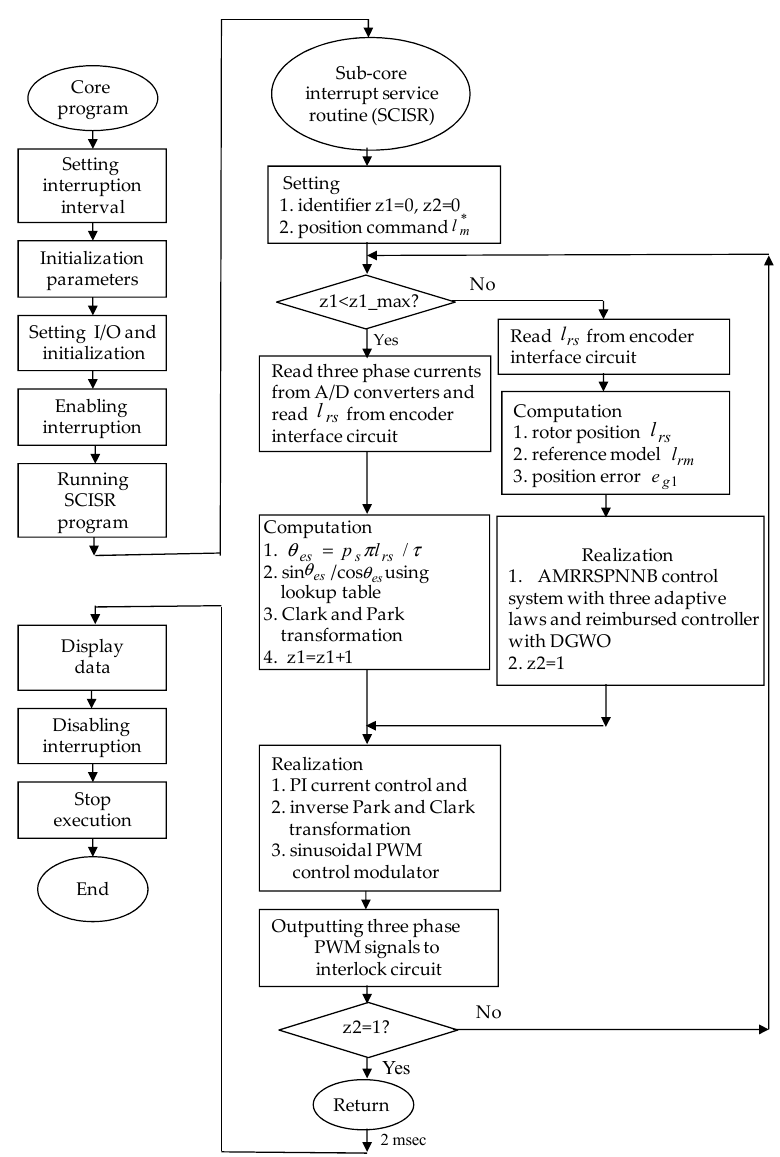
Figure 7. Flowchart of the enforcing program utilized by the DSP control system.